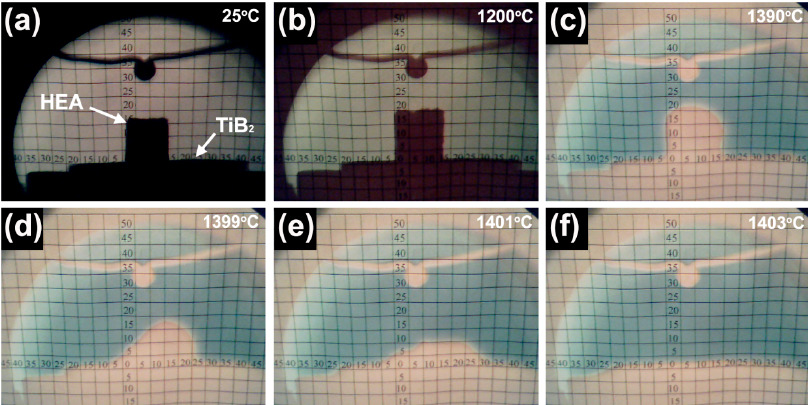
Figure 2. Wetting ability test between CoCrFeNiAl high-entropy alloy and TiB 2 substrate at different temperatures: ( a ) 25 ◦ C; ( b ) 1200 ◦ C; ( c ) 1390 ◦ C; ( d ) 1399 ◦ C; ( e ) 1401 ◦ C and ( f ) 1403 ◦ C.